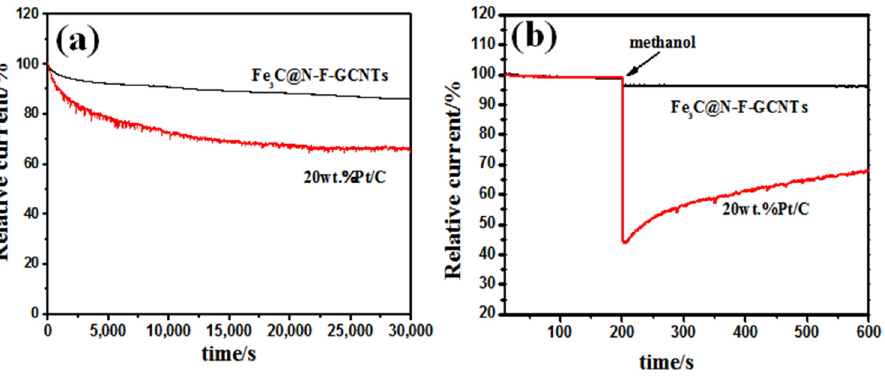
Figure 6. Chronoamperometric response for Fe 3 C@N-F-GCNTs and Pt/C at 0.6 V (900 rpm) over a time span of 30,000 s ( a ); chronoamperometric responses for Fe 3 C@N-F-GCNTs and Pt/C at 0.6 V with the addition of 3 M methanol at around 200 s (900 rpm) ( b ).